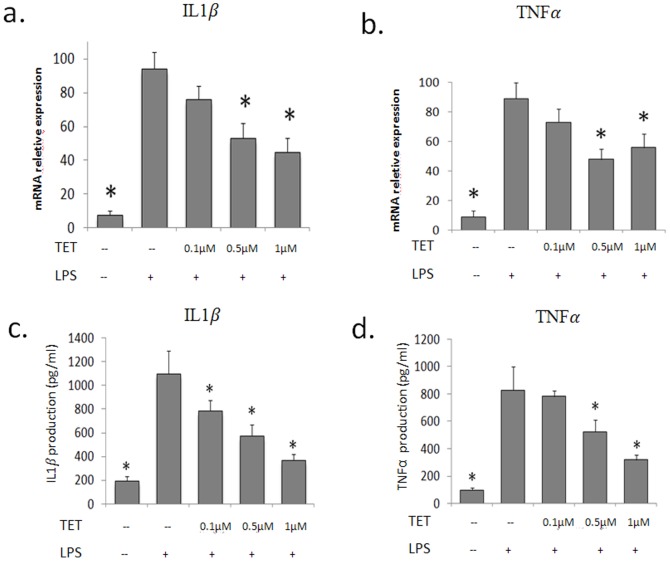
The expression of IL1β and TNFα was attenuated by TET in BV2 cells.BV2 cells were treated with TET at working concentrations for 2 h. Then, LPS was added to each plate and incubated at 37°C for an additional 24 h. Then, the supernatant was collected and stored at −80°C for further ELISA assay. The cells were lysed for RNA extraction. Fig. 5a–5b: The mRNA expression of IL1β and TNFα was determined by real-time RT-PCR. Fig. 5c–5d: The production of IL1β and TNFα was measured by enzyme-linked immunosorbent assay (ELISA). Results were the mean ± S.D. from three independent experiments performed in triplicate. * P<0.05 compared with the LPS group.